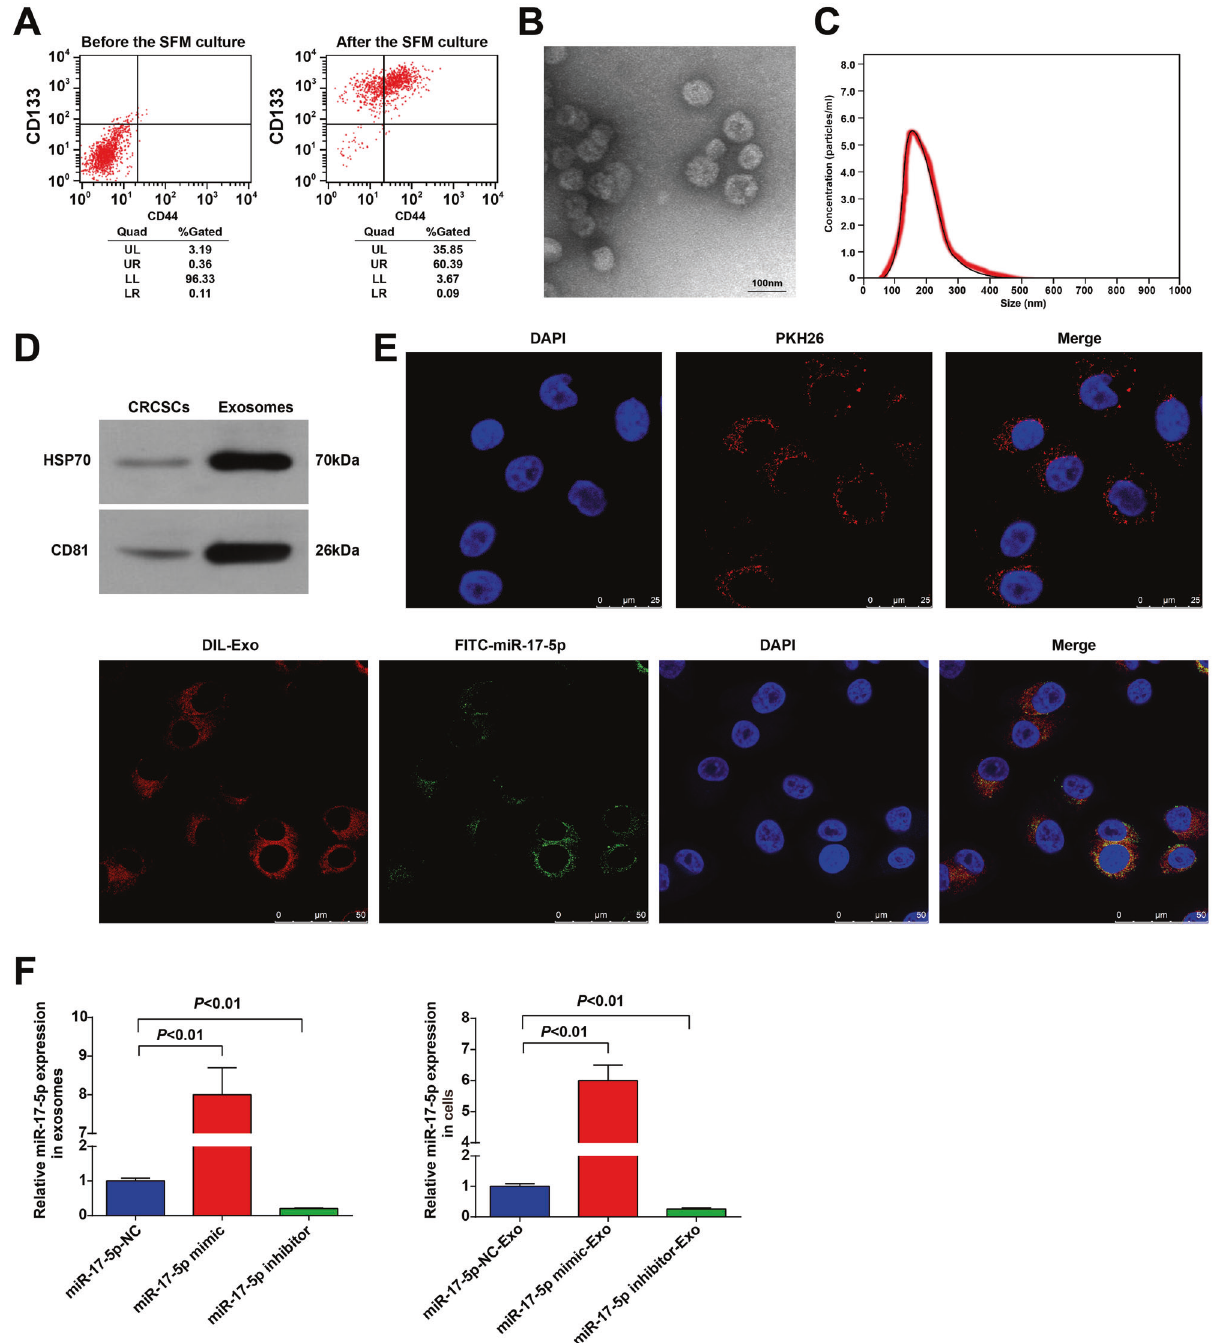
Fig. 1 CRC stem cell sorting and exosome identi fi cation. A CD133 + CD44 + CRCSC were sorted by fl ow cytometry; B the exosome morphology was observed using a TEM; C the diameter distribution and concentration of exosomes were detected by NTA; D the exosome markers HSP70 and CD81 in CRCSCs and exosomes were detected by western blot analysis; E the entry of exosomes that labeled with fl uorescent PKH67 to HCT116 cells was observed by immuno fl uorescence microscopy; the co-localization of labeled fl uorescent FITC-miR-17- 5p and exosomes in HTC116 cells was observed by immuno fl uorescence microscopy; FITC-miR-17-5p-labeled exosomes were green; DAPI- stained nuclei were blue; DIL-labeled exosomes were red; F miR-17-5p expression in cells and exosomes detected using RT-qPCR. The cell experiments were repeated three times; P < 0.05; the measurement data were expressed as mean ± standard deviation. SPOP overexpression inhibits biological functions of HCT116 immunoprecipitation (Fig. 6F). The results of RT-qPCR and Western cells blot analysis implied that SPOP was downregulated (upregulated) HCT116 cells were transfected with pcDNA-SPOP to alter SPOP after miR-17-5p expression was increased (decreased) (Fig. 6G). expression, and we found that SPOP expression was successfully These fi ndings indicated the targeting relationship between miR- increased after the transfection (Fig. 7A, B). Then, the biological 17-5p and SPOP. Cell Death Discovery (2022)